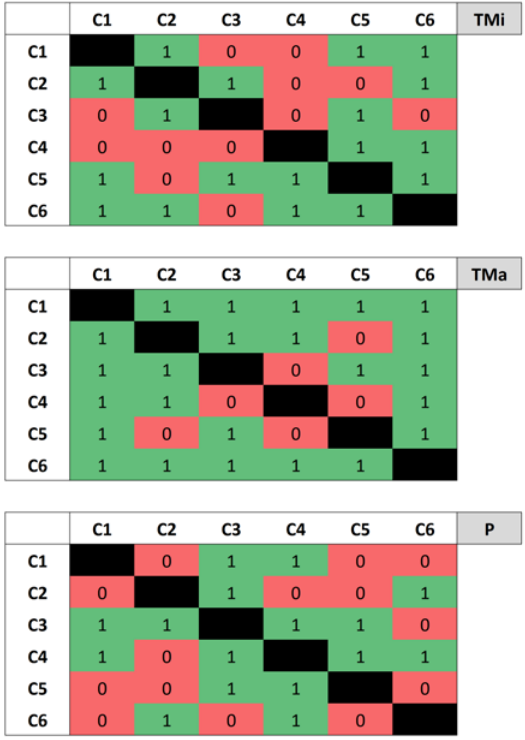
Figure 13. Significance of differences between the cluster mean values of TMi , TMa, and P . Red and green cells show not significant and significant difference values.